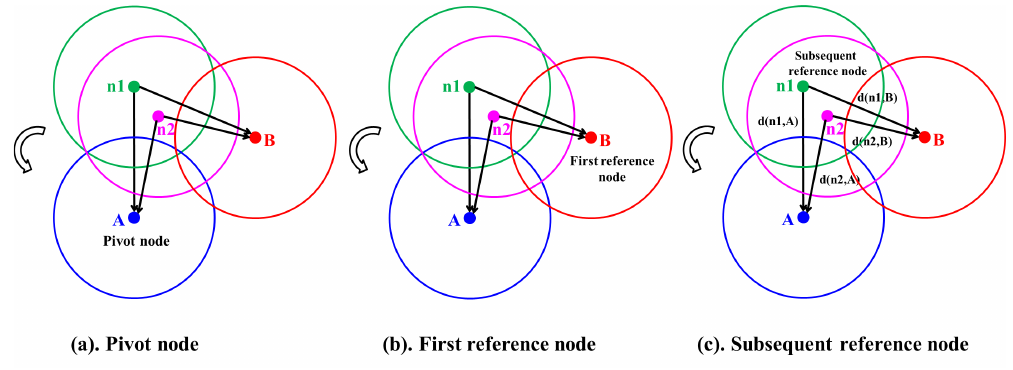
Figure 4. Example of the formation of groups of node A. ( a ) Pivot node selection; ( b ) First reference node selection; ( c ) Subsequent reference node